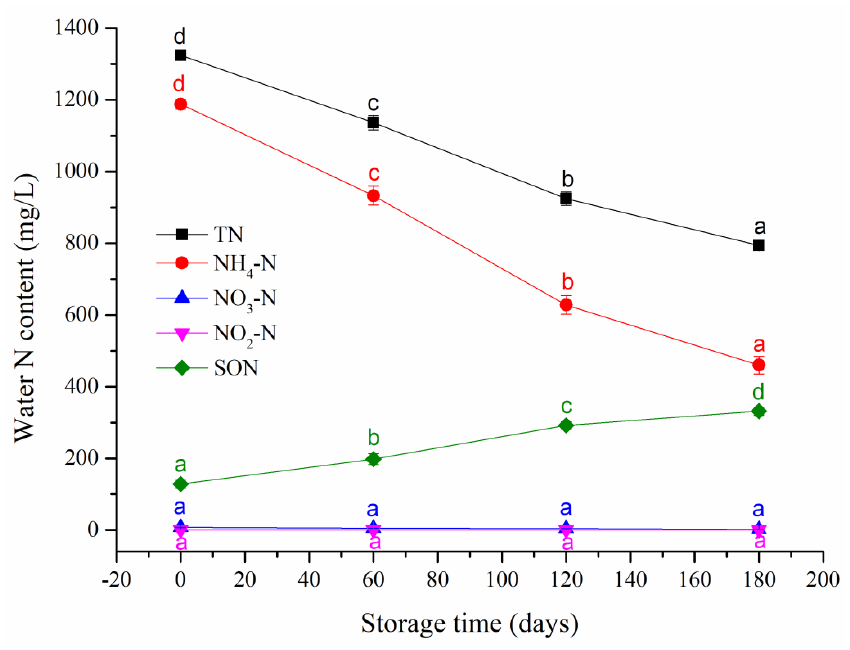
Figure 2. Contents of total nitrogen (TN), NH 4 ‐ N, NO 3 ‐ N, NO 2 ‐ N, and soluble organic nitrogen (SON) in swine wastewater at different storage times. Data are the means of three replications, and bars indicate standard deviation. Different letters indicate significance at p < 0.05.